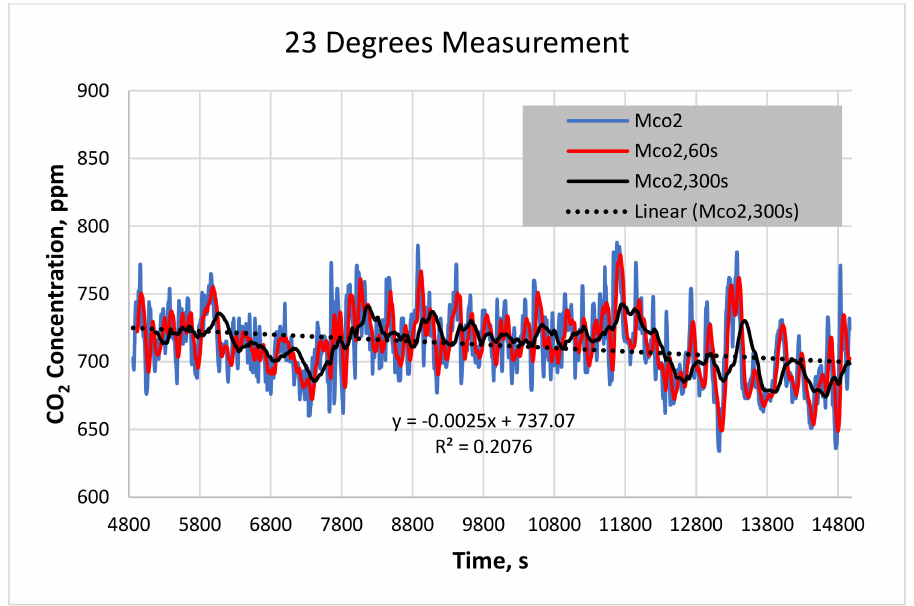
Figure 20. CO 2 concentration, exposure at 23 ◦ C: instantaneous data Mco 2 (blue curve); evolution curve of the CO 2 concentration, time-averaged for 60 s, Mco 2,60s (red curve); and evolution curve of the CO 2 concentration, time-averaged for 300 s, Mco 2,300s (black curve). Figure 21 visualises the results for the monitored physiological parameters: oxygen saturation pressure (SpO2), pulse rate (PR), end-tidal CO 2 (EtCO2), and respiration rate (RR). They are presented in the form of the instantaneous data and the evolution curves for each parameter, time-averaged for 1200 s. The averaging interval is chosen to be 1200 s, as it is equal to the period of exposure to 27 ◦ C and is half of the transition period from 27 ◦ C to 23 ◦ C.